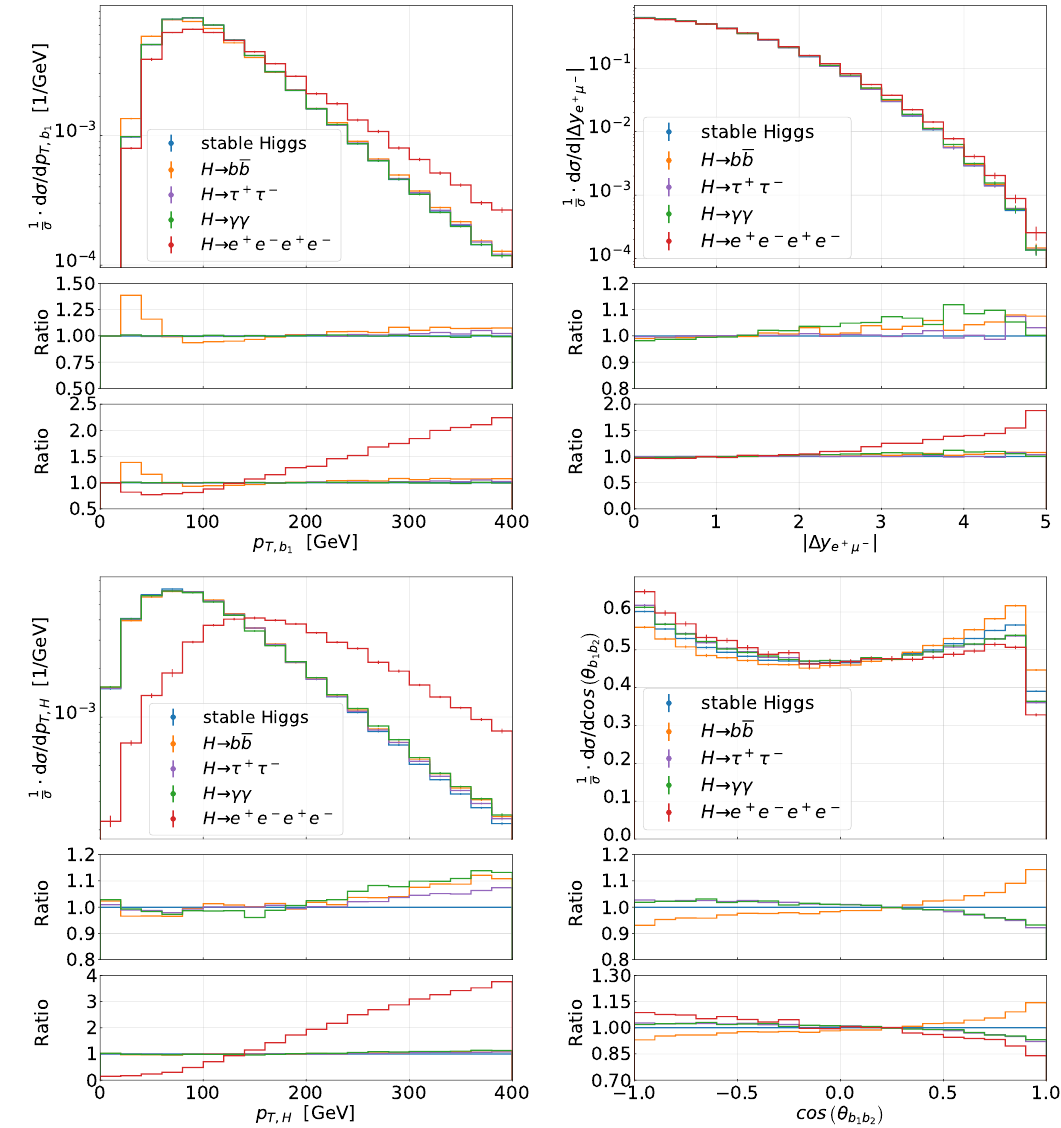
, | ∆ y | , p T,H and e + µ − √ 1 s = 13 TeV. Results are given for